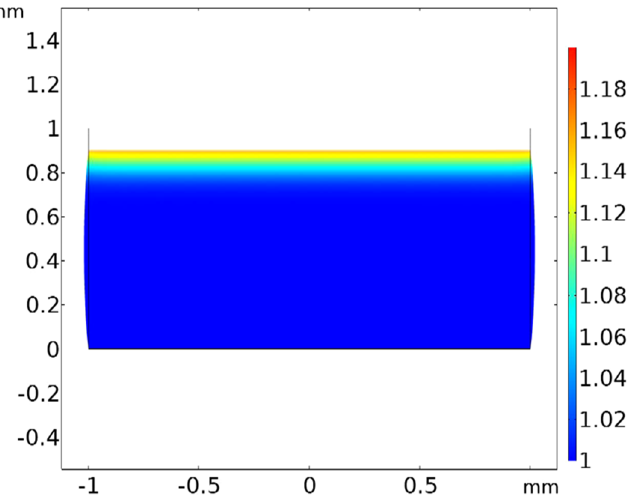
Figure 11. Steady-state relative concentration plot of compressed PVC gel sample with 0.1 compres- sive strain displaying higher plasticizer concentrations in a layer approximately 100 μ m near the interfacial layer. interfacial